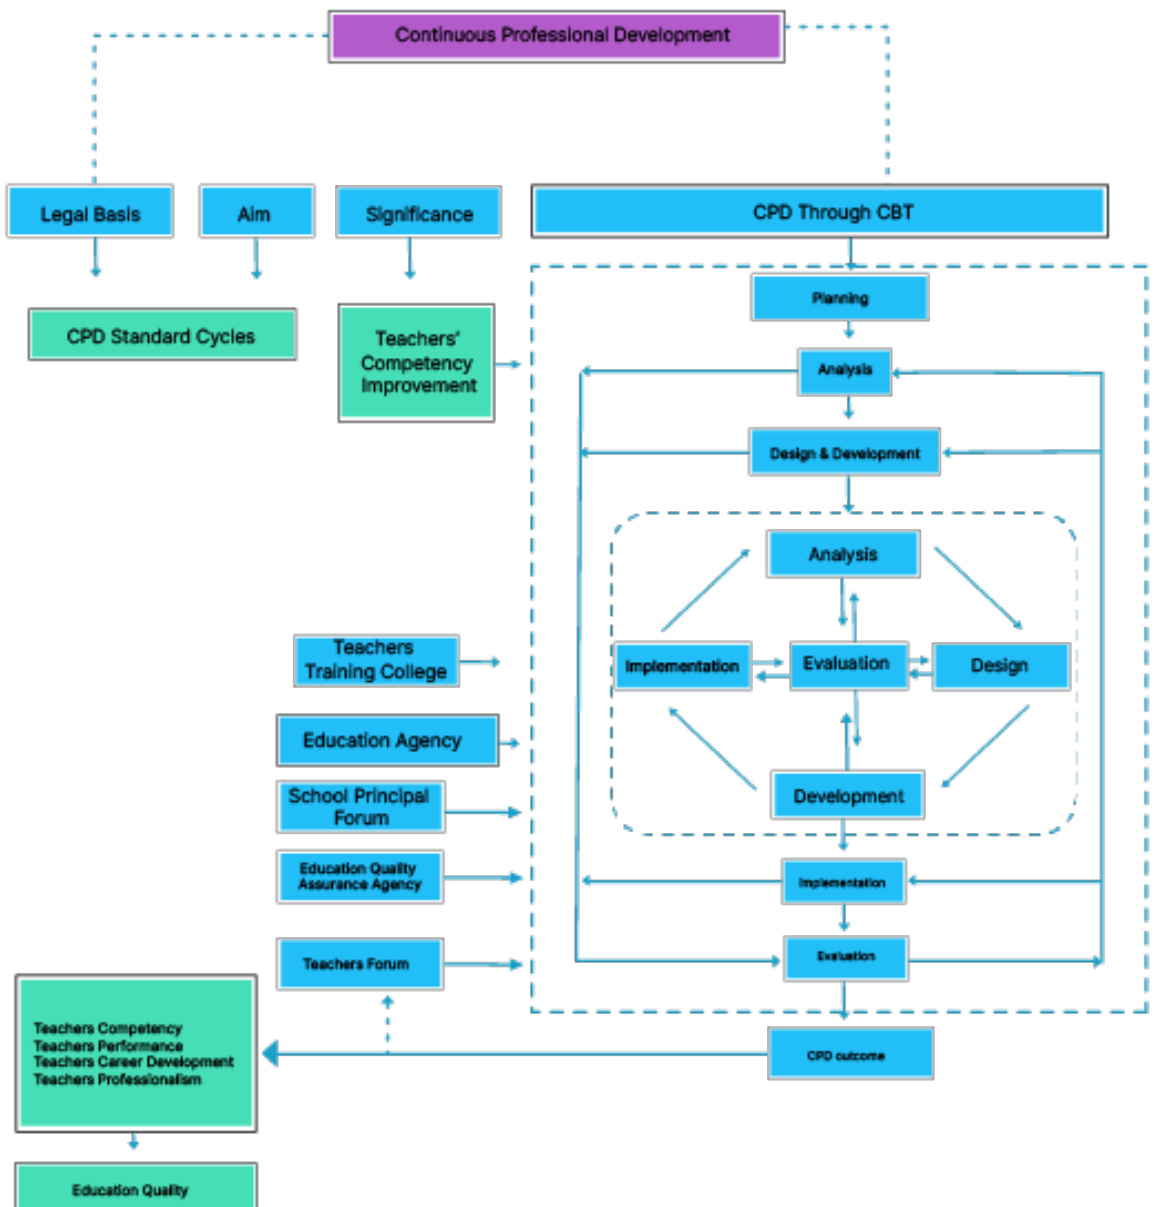
Figure 5. Final model of CPD through